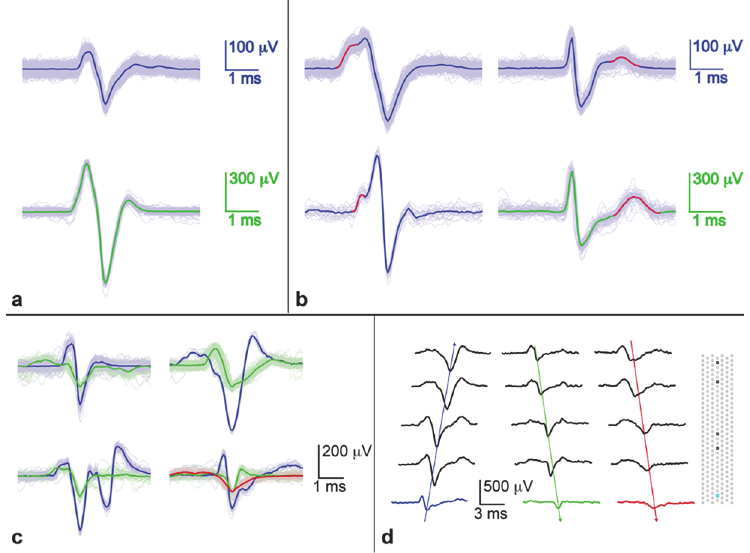
Fig 7. Spontaneous spike shapes on different electrodes in the channels during a single recording session. Spike shapes on a given electrode were remarkably consistent and reproducible over short time periods. (a) The ‘ classical ’ axonal signal, which is biphasic (blue) or tri-phasic (green), starting with a positive peak, was the shape most often seen. (b) Variations on the classical shape showed either a bump before the first peak (first column) or a bump just after the spike (second column). Colored scale bars correspond to waveforms of the same color. (c) Complex multiple spike shapes in channels. A single spike shape propagated in a single direction while different shapes often propagated in opposite directions. In all cases many trials are shown and median traces are overlaid. (d) Timing of different spike shapes shown in c in the lower right plot; the positions of the electrodes are shown on the right side: the electrode of interest is light blue, and the other electrodes in the channel are outlined in black. Electrode pitch is 17 μ m.